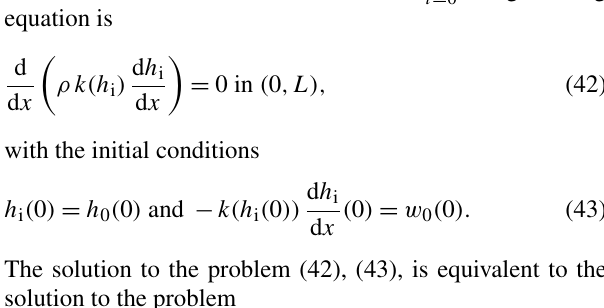
(1) c f = 2 . 27 × 10 − 5 g/cm 3 , c e = 9 . 35 × 10 − 6 g/cm 3 , (2) c f = 2 . 41 × 10 − 5 g/cm 3 , c e = 9 . 94 × 10 − 6 g/cm 3 , (3) c f = 2 . 56 × 10 − 5 g/cm 3 , c e = 1 . 06 × 10 − 5 g/cm 3